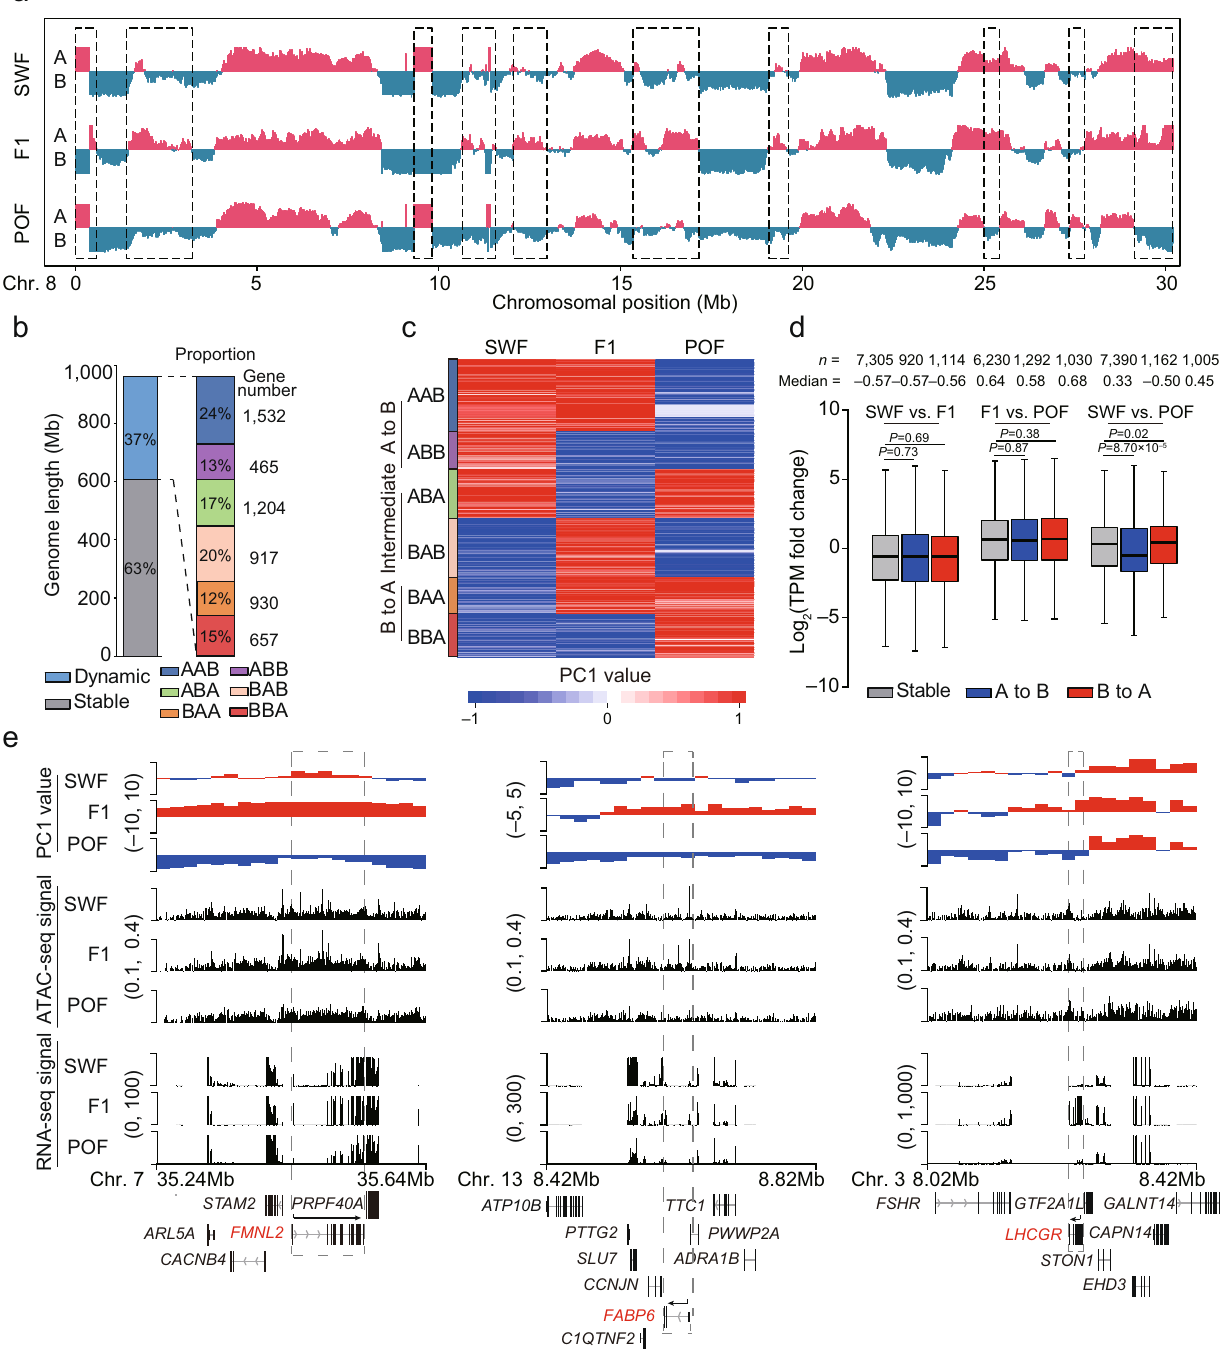
Fig. 3 Compartmentalization dynamics in chicken granulosa cells during folliculogenesis. a Compartment switches (gray dotted boxes) on chromosome 8. A/B compartments are indicated by PC1 values. b Genomic lengths and proportions of stable and dynamic compartments. Dynamic compartments are classi fi ed into six types of transitions. c Heatmap of the PC1 values for the compartment switching regions. d Expression levels of DEGs located in compartment switching regions (from A to B: blue; from B to A: red) compared to those in stable compartments (gray). P values were calculated using two- sided Wilcoxon rank-sum test. In the boxplot, the internal line indicates the median, the box limits indicate the upper and lower quartiles and the whiskers extend to 1.5 IQR from the quartiles. e Three representative functional genes (red) subject to compartment switching during folliculogenesis, including FMNL2, FABP6 , and LHCGR . The dashed line boxes indicate the chromosomal locations of the interested genes. The tracks show the compartment (top panels), ATAC (middle panels), and gene expression (bottom panels) features within 400 kb. Gene structures are indicated below the tracks. The black arrows indicate the direction of the gene transcription. Source data are provided as a Source Data fi